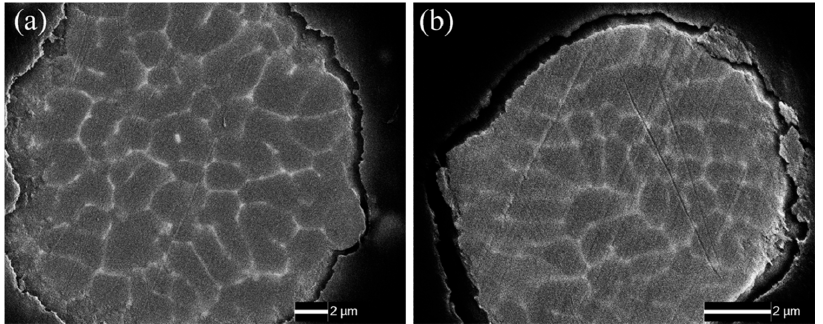
Figure 1. Scanning electron microscope (SEM) images of cross-section to unsintered 7075 aluminium powders, ( a ) large powder with 100 ± 15 μ m diameter and ( b ) small powder with 10 ± 5 μ m diameter.